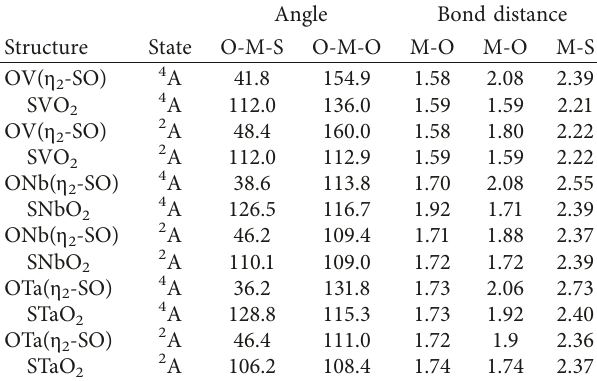
Table 1: Geometrical parameters (degrees and ˚A) at the stationary points located for the metal oxide OV( SVO 2 compounds.